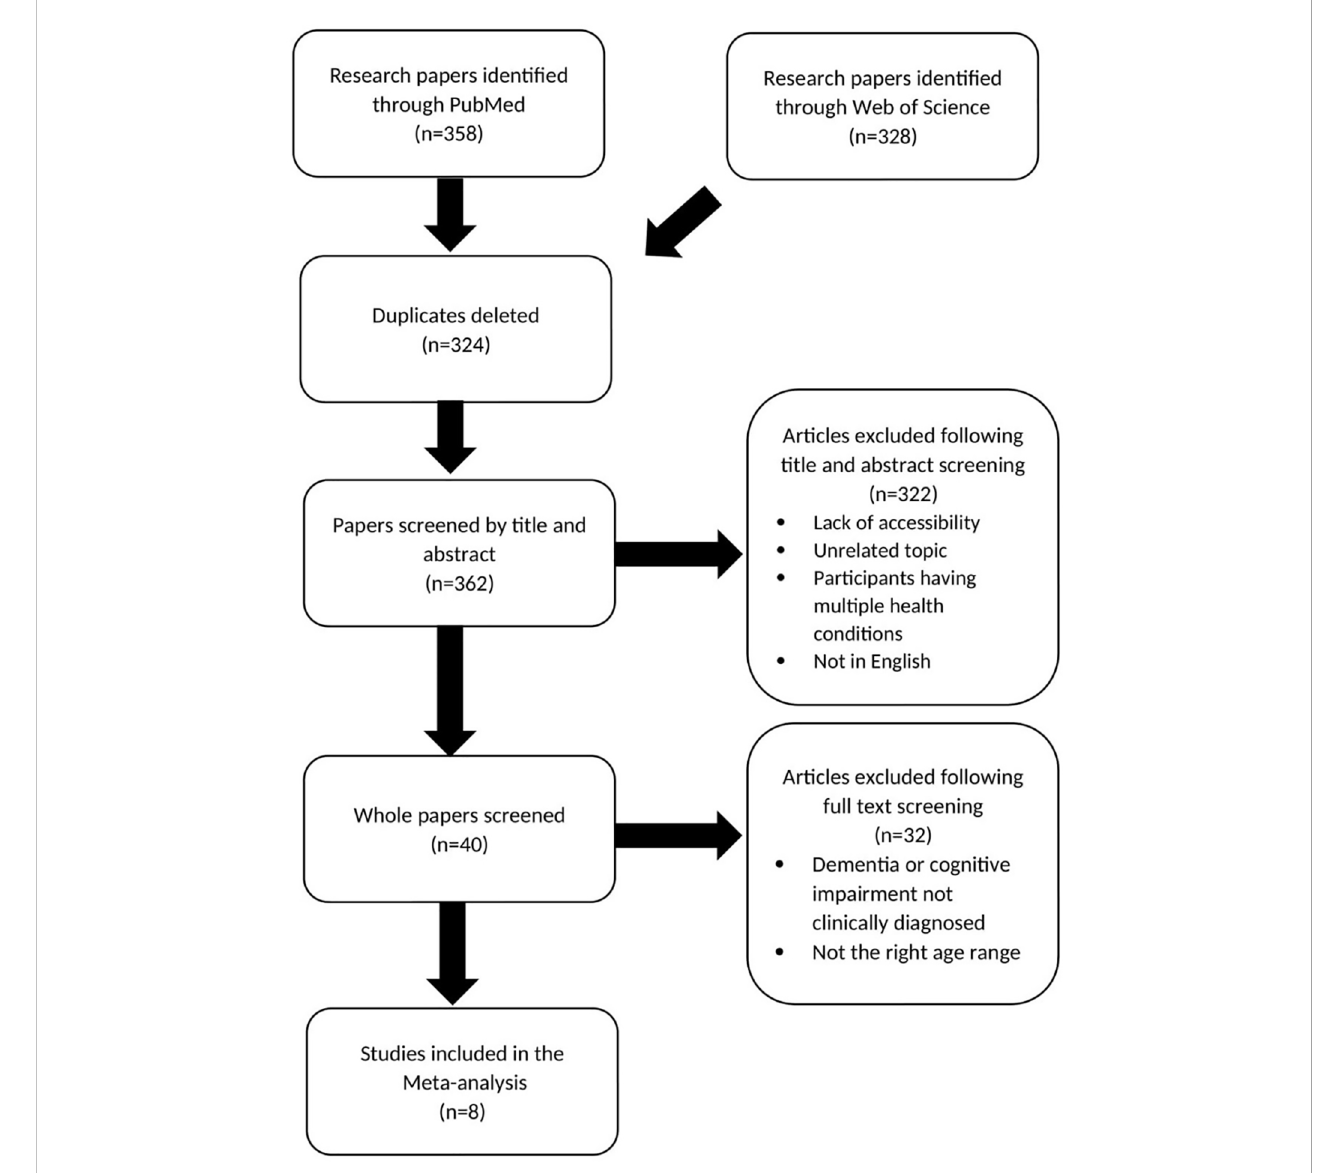
FIGURE 1 Prisma chart showing paper selection for meta-analysis investigating IBD and RA association with risk of